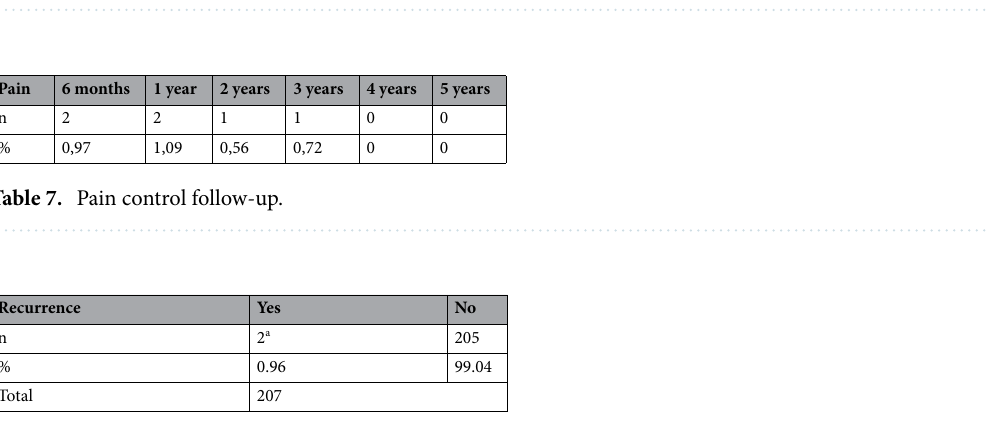
Table 6. Follow-Up.